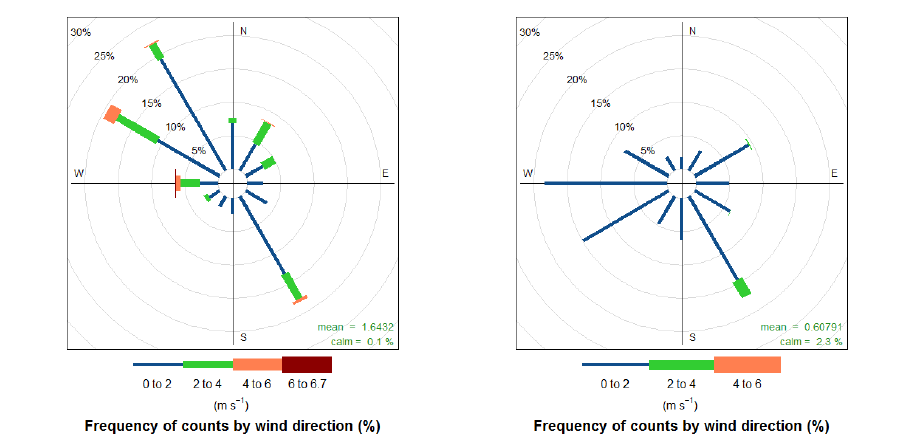
Figure 7. Wind rose (Arboretum, left; ˇCerná Pole,